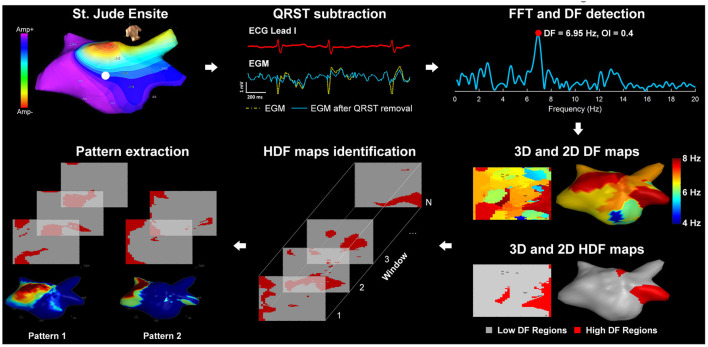
Diagram of the signal processing steps of the atrial electrograms: (1) St. Jude Ensite: left atrial Geometry isopotential map exported from Ensite Velocity System; (2) QRST subtraction: Electrograms using one ECG lead as reference; (3) FFT and DF detection: power spectrum of the current non-contact atrial signal and DF identification; (4) 3D and 2D DF/HDF maps: MATLAB reconstructed 3D Atrial geometry with color-coded DF/HDF and transformation to 2D uniform grid; (5) HDF maps identification: sequential 2D HDF maps used as input of the pattern extraction algorithm; (6) Pattern extraction: pattern extraction algorithm identifying recurrent spatial patterns.